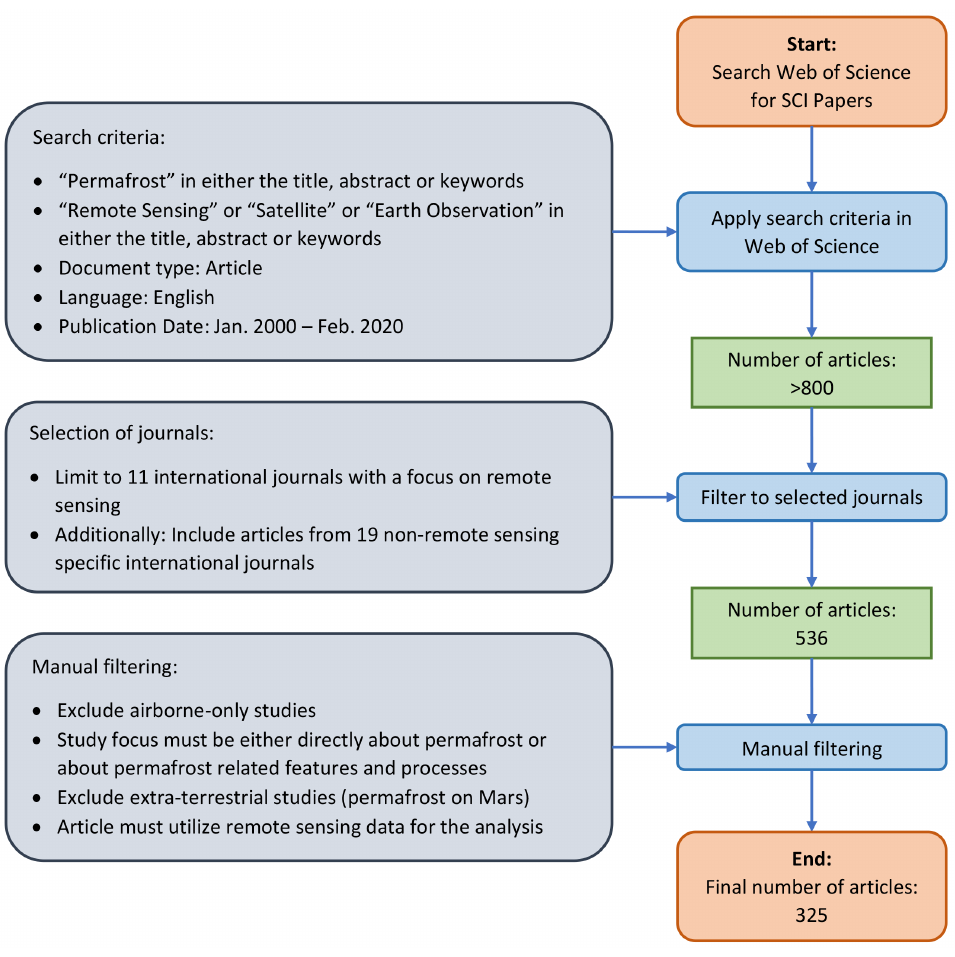
Figure 2. Overview of the selection process for relevant articles within this